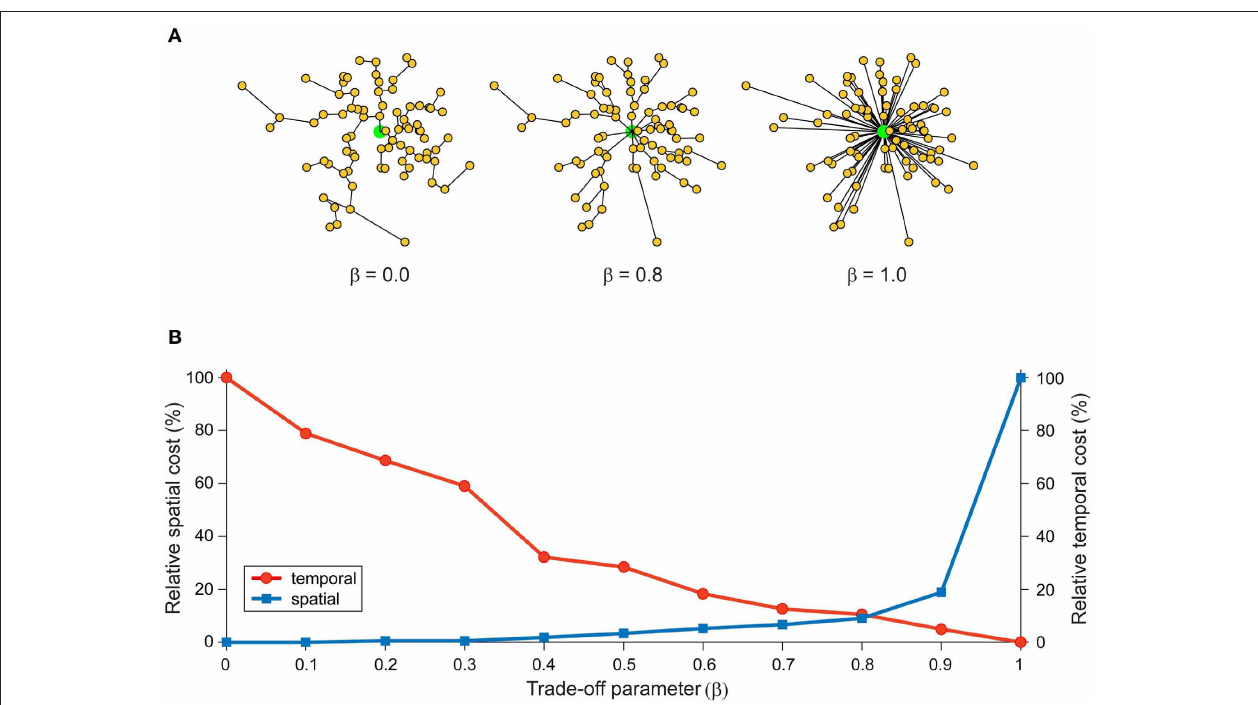
FIGURE 2 | Spatial and temporal cost trade-off alters arbor morphology. An example network consists of 80 labeled vertices (small yellow filled circles) plus a root vertex (large green filled circle). Here, total wiring cost = spatial cost + ( β × temporal cost), where the parameter β , which varies between 0 and 1, is used to trade-off spatial construction cost against temporal routing cost. (A) Artificial arbor structures optimized for different values of a cost trade-off parameter, β = 0 . 0 (spatial cost